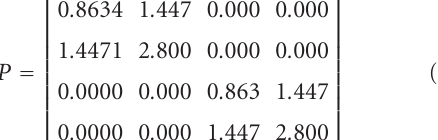
Figure 7: Minimum distance between vehicles in the presence of a communication